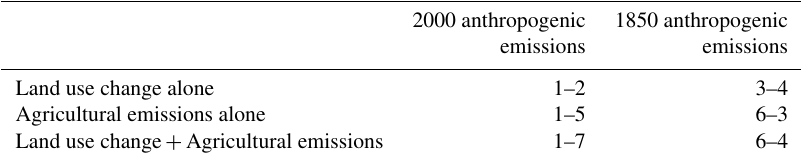
Table 2. Road map for how simulations are combined to estimate the impact of land use change and the associated change in agricultural emissions on air